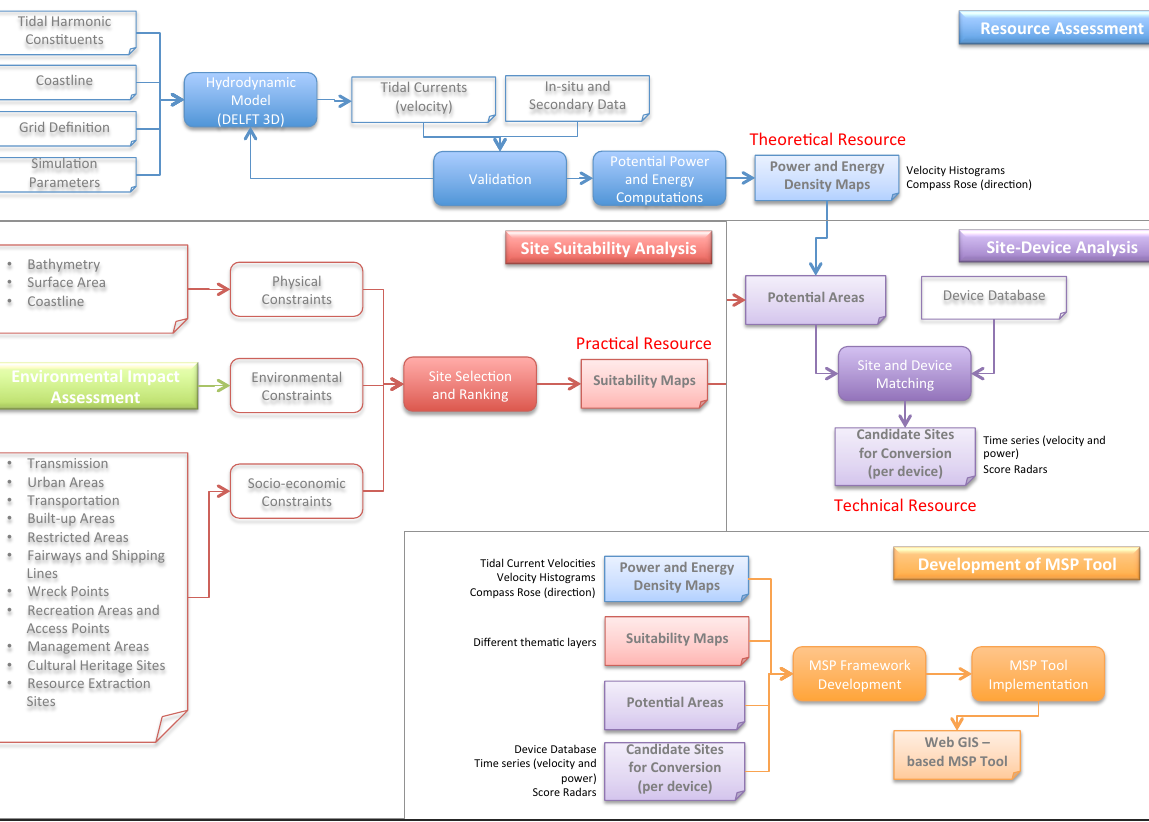
Figure 1. Conceptual framework for the development of the MSP tool.